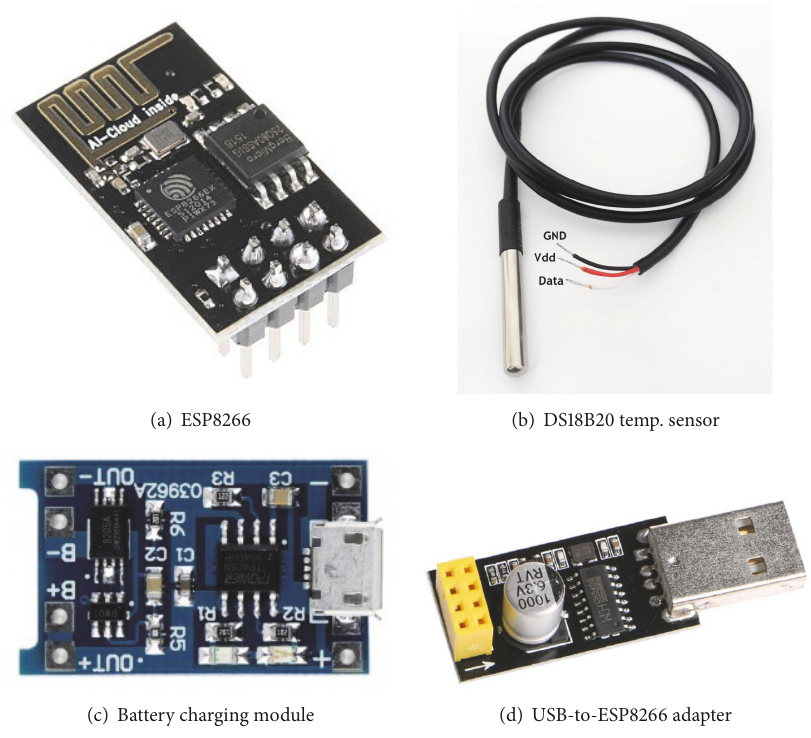
Figure 7: Key components that were used to build a real-time published temperature